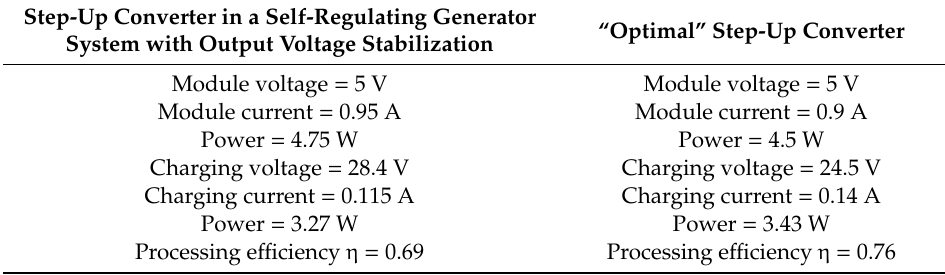
Table 3. Electrical parameters of various investigated types of step-up